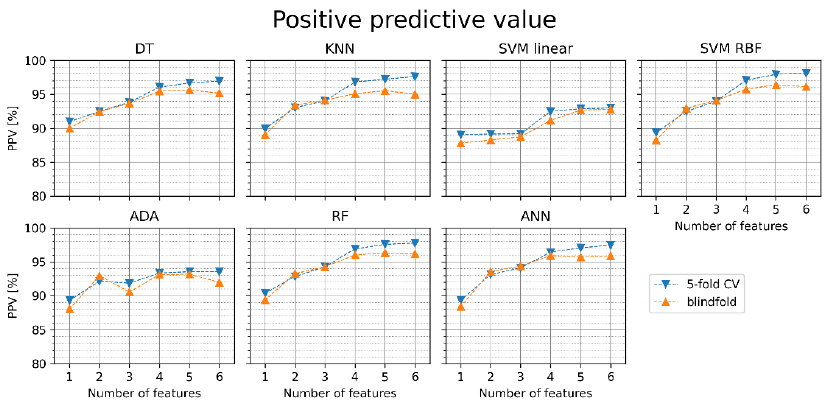
Figure 8. Positive predictive value (PPV) of AF detection for different classifiers with sets of one to six features (orange points—blindfold validation, blue points—5-fold cross-validation). DT—decision tree, KNN—K nearest neighbors, SVM linear—support vector machine with linear kernel, SVM RBF—support vector machine with radial basis function kernel, ADA—Ada Boost, RF—random forest, ANN—artificial neural network.